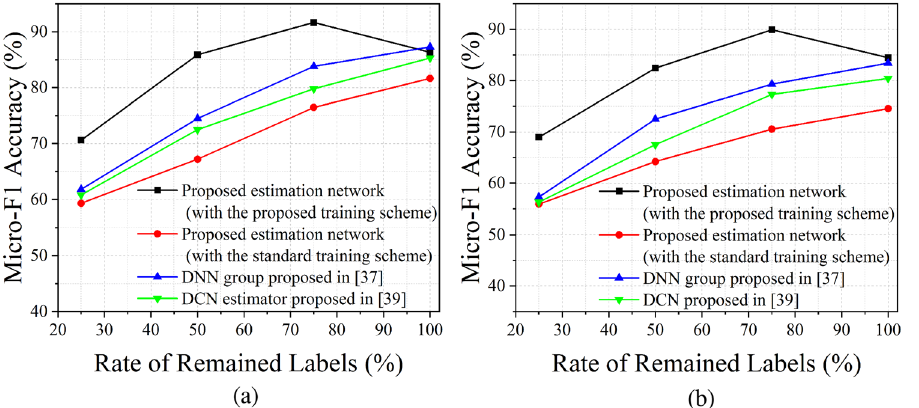
Figure 3. Micro-F1 accuracy comparison. ( a ) Training accuracy, ( b ) validation accuracy.